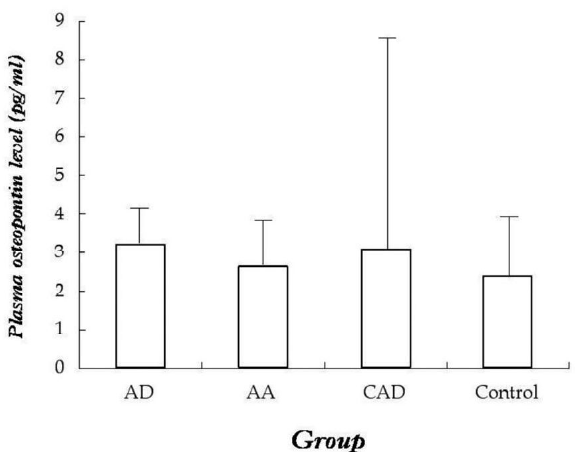
Fig. 6 - Plasma osteopontin concentrations detected by ELISA. P = 0.602 for AD vs. AA, P = 0.863 for AD vs. CAD, P = 0.812 for AD vs. healthy control, P = 0.958 for AA vs. CAD, P= 0.361 for AD vs. healthy control, and P = 0.649 for CAD vs. healthy control.